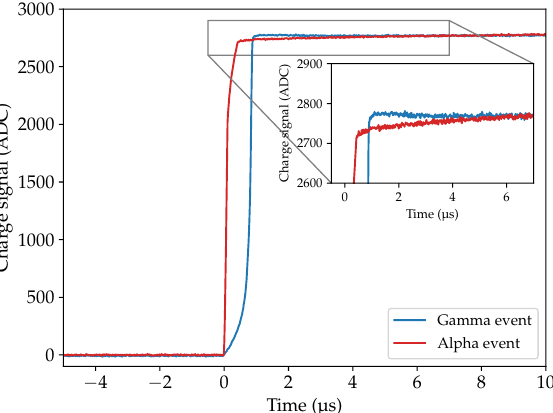
Figure 6. Typical examples of a bulk gamma event (blue curve) and of a surface alpha event (red curve) with the same energy. The waveforms were recorded using the PPC detector under study. The baseline and pole-zero-corrected alpha signal features a slowly rising tail (see inset). This component can be explained as due to DCR. Due to its proximity to the signal readout electrode, the rise time of the surface alpha event is shorter (steeply rising leading edge) than the rise time of the gamma bulk